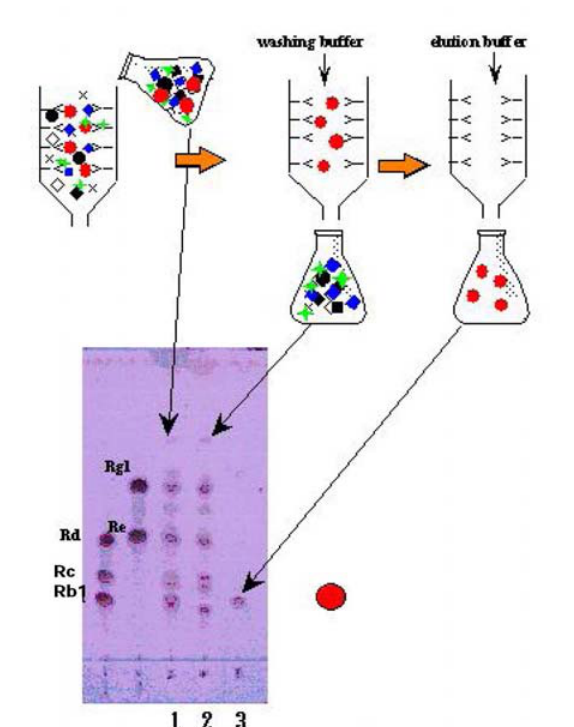
Figure 7. Preparation of knock-out extract eliminated ginsenoside-Rb1 from Panax ginseng crude extract using immunoaffinity column conjugated with anti-ginsenoside-Rb1